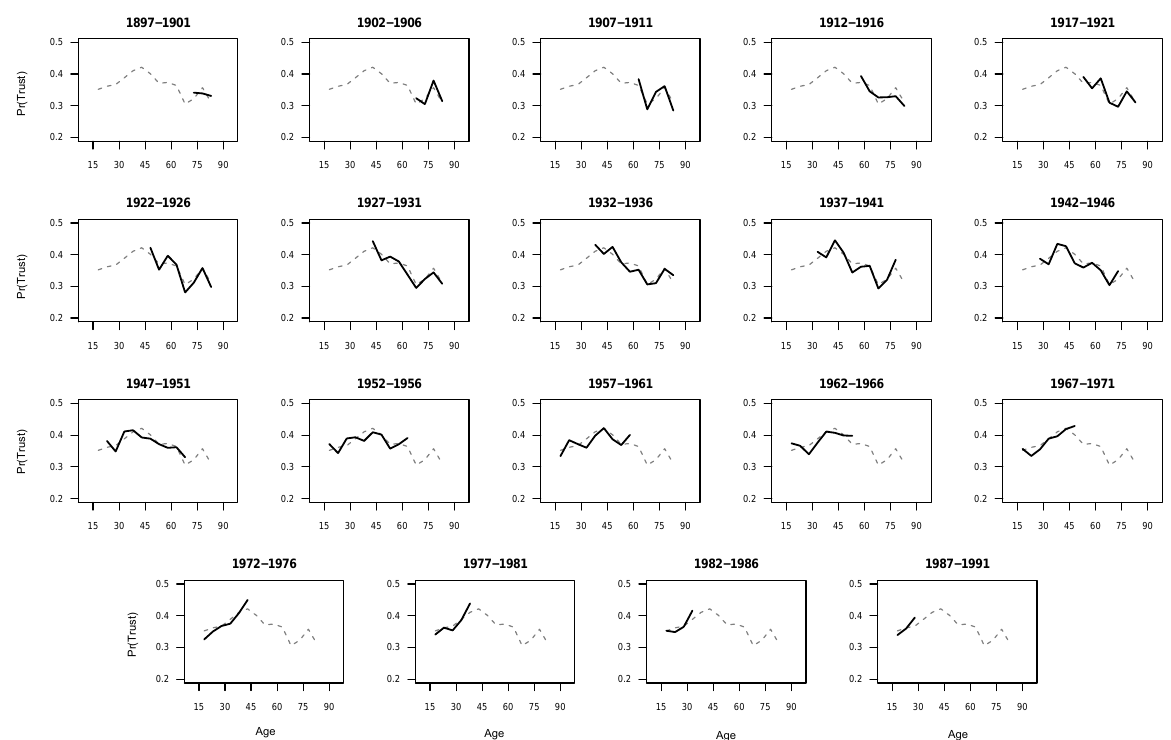
Figure 7: Trellis plot of local diachronic age curves. Notes: Each panel displays the (overall) diachronic age curve overlaid with local diachronic age curves. Horizontal axes are age in years, whereas vertical axes are predicted probability of social trust. Calculations for the local curves are based on θ 1 ( i − i ∗ ) + for i = 1, . . . , I in each cohort k . Local curves are shown with solid lines, whereas the overall curve is shown with a dashed line. Only cohorts with three or more age groups are displayed. All estimates are based on a diachronic L-APC logistic regression model. Outcome is social trust, coded so that 1 = “can trust” while 0 = “can’t be too careful” or “depends.” Results adjusted using sampling